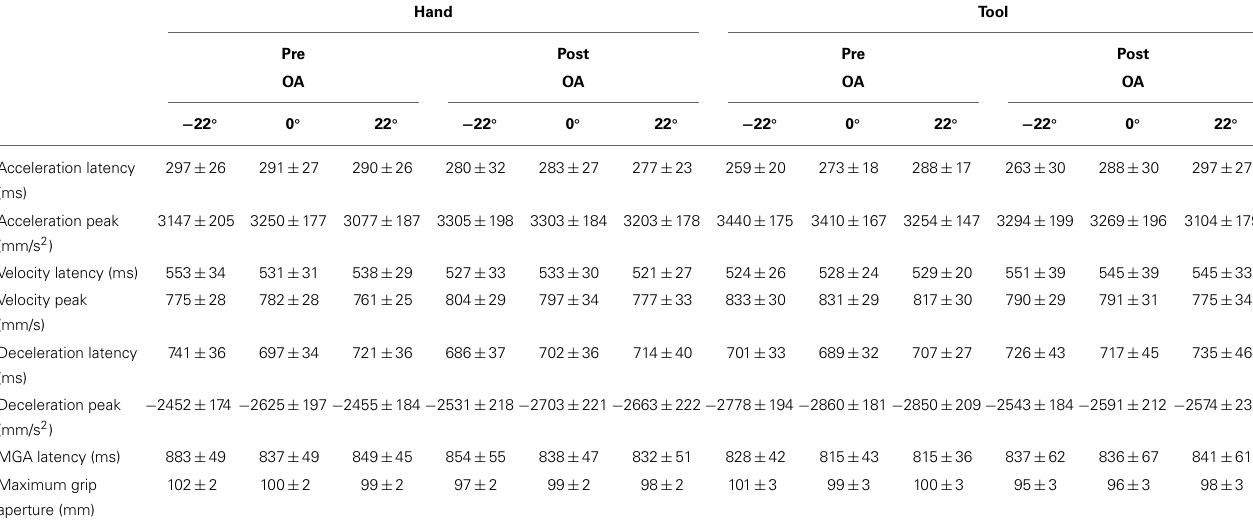
Table 2 | Main values ± 1 s.e.m. of each kinematic parameter according to the full factorial design. Hand